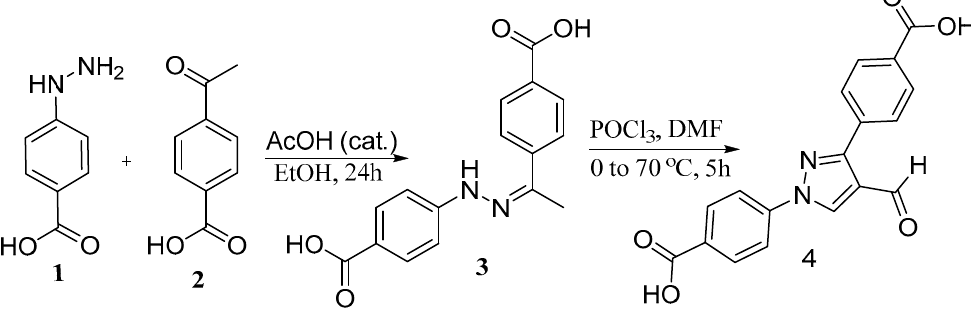
Figure 1. Pyrazole derived hydrazones as potent anti- Acinetobacter baumannii agents.